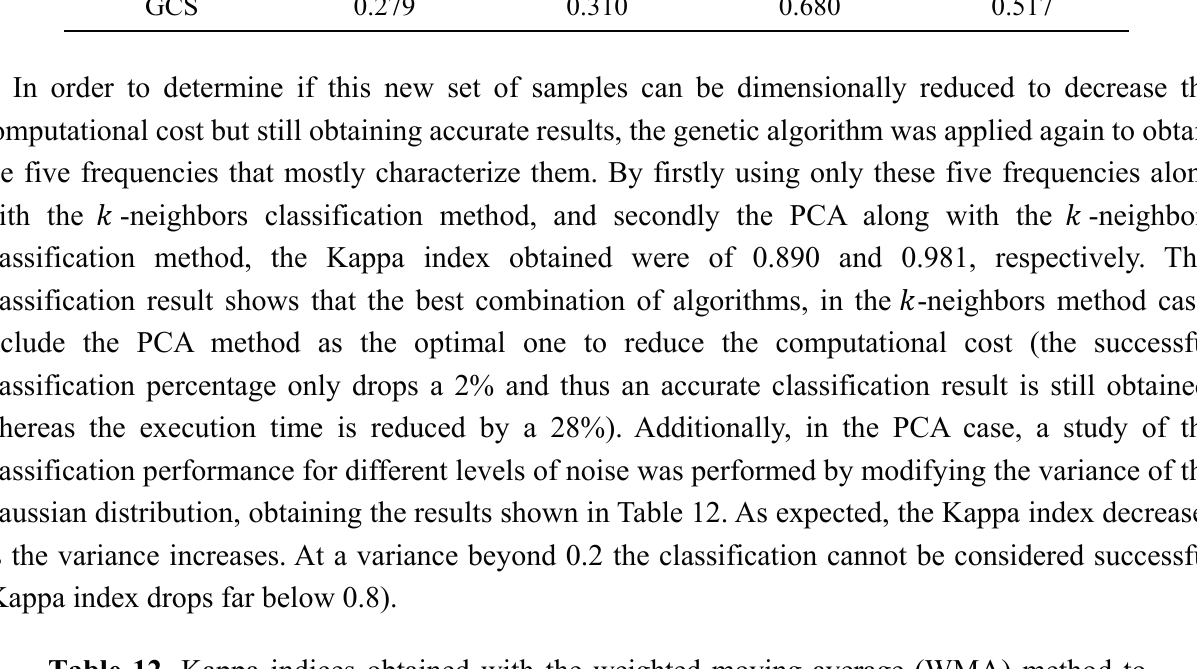
Table 12. Kappa indices obtained with the weighted moving average (WMA) method to denoise, the standard normal variate (SNV) method to normalize, the principal component analysis (PCA) method for a dimensional reduction and the (cid:1863) -neighbors to classify, by using the degraded samples with four different variances ( (cid:2026) ) of the noise Gaussian distribution. (cid:2252) = (cid:2777). (cid:2777)(cid:2780) (cid:2252) = (cid:2777). (cid:2777)(cid:2783) (cid:2252) = (cid:2777).